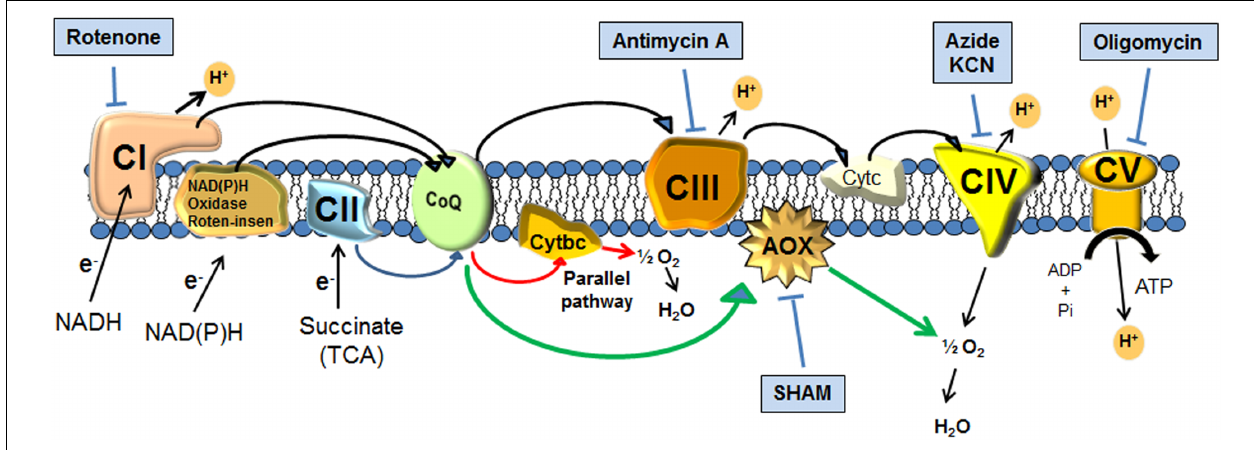
FIGURE 1 | Scheme of the mitochondrial respiratory chain (modified from Alonso-Monge et al., 2009) and of the different electron transfer pathways: classical, alternative rotenone-insensitive, parallel (red arrows) and alternative oxidases (green arrows). The scheme also represents the target of the main respiratory